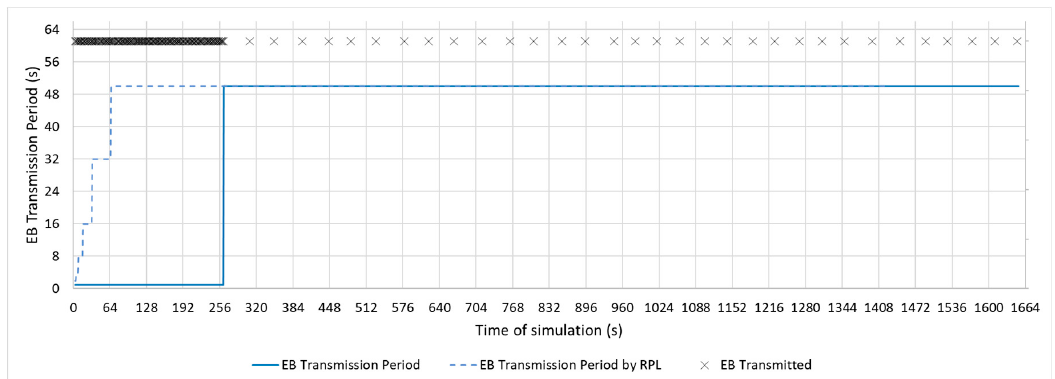
Figure 14. MT configuration.